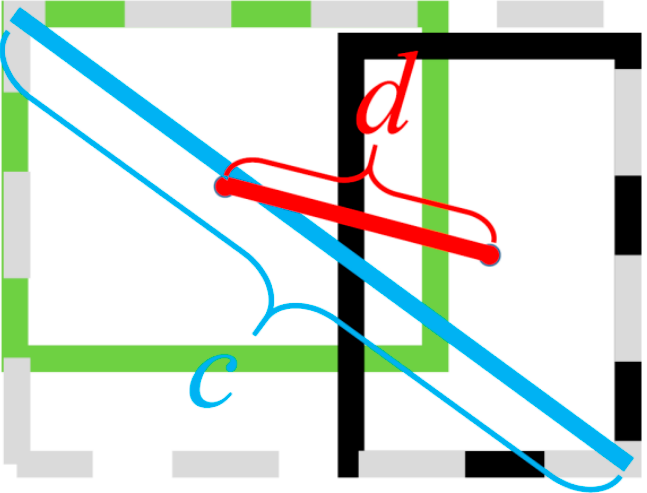
Figure 10. Prediction box P and True box GT .